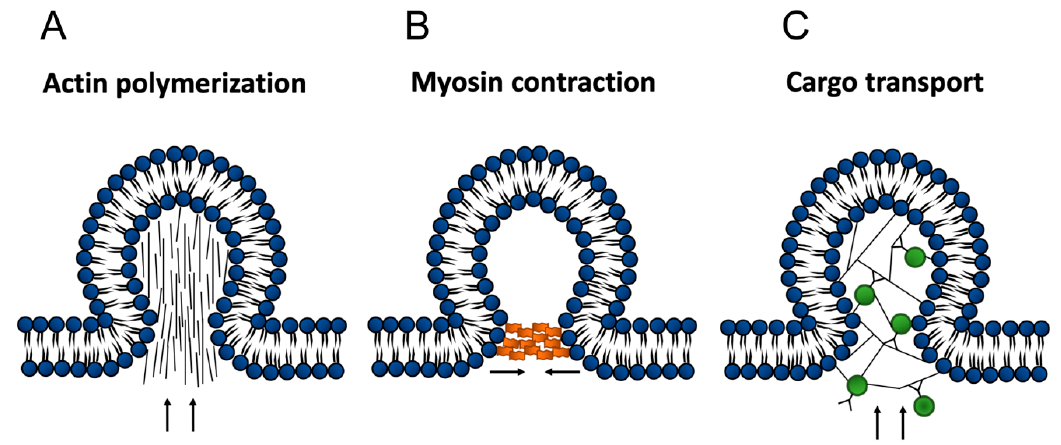
Figure 4. Three ways that the actin cytoskeleton might be involved in extracellular vesicle (EV) formation. ( A ) Microfilaments may push against membranes using force generated by polymerization of actin. ( B ) Myosin motors may materials to the site of EV formation for packaging. ( C ) Myosin contraction may play a role in the scission of the EV. In each of these cases, elements of the actin cytoskeleton may be trapped in the EVs as the result of the cytoskeleton’s involvement in the EV formation process. Arrows denote the direction filaments push into membrane in actin piloymerization, or the direction of cargo transport.